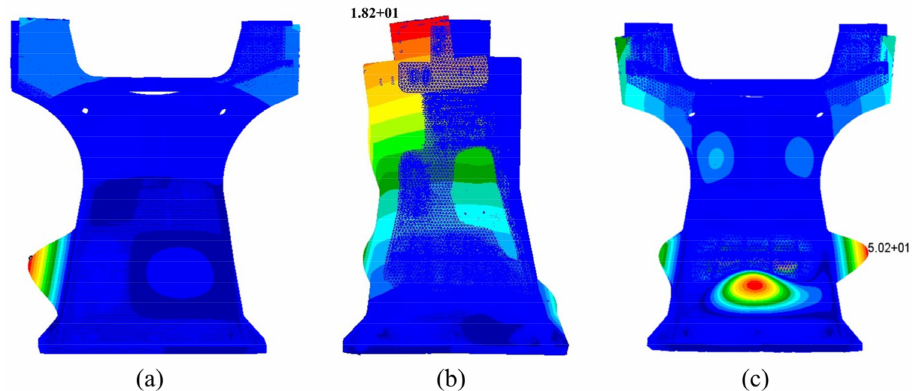
Figure 7. Vibration modes of bionic optimized structure. ( a ) X-direction fundamental frequency. ( b ) Y-direction fundamental frequency. ( c ) Z-direction fundamental frequency.